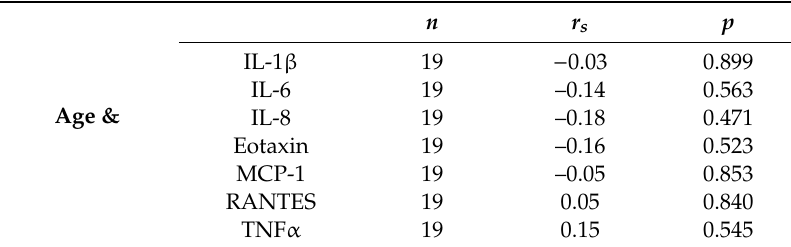
Table 5. Correlations between IL-1 β , IL-6, IL-8, RANTES, eotaxin, MCP-1, and TNF α salivary levels and age in ASD group. The strength of the correlations was determined using Spearman’s rank correlation coe ffi cient; p < 0.05 was considered statistically